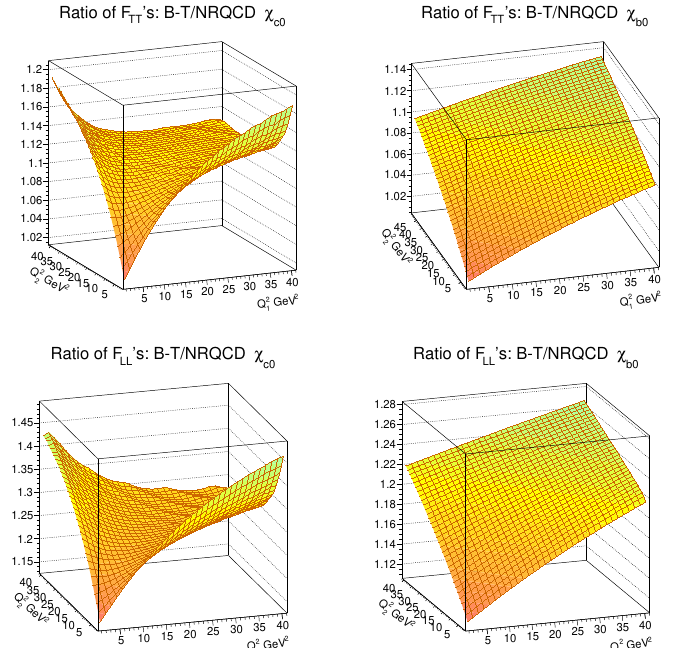
Figure 6 . The ratio of light front to the NRQCD form factors, ( F TT | upper panels), ( F LL | lower panels) for (cid:31) c 0 and (cid:31) b 0 . Here, for illustration, the LF form factor is calculated from wave